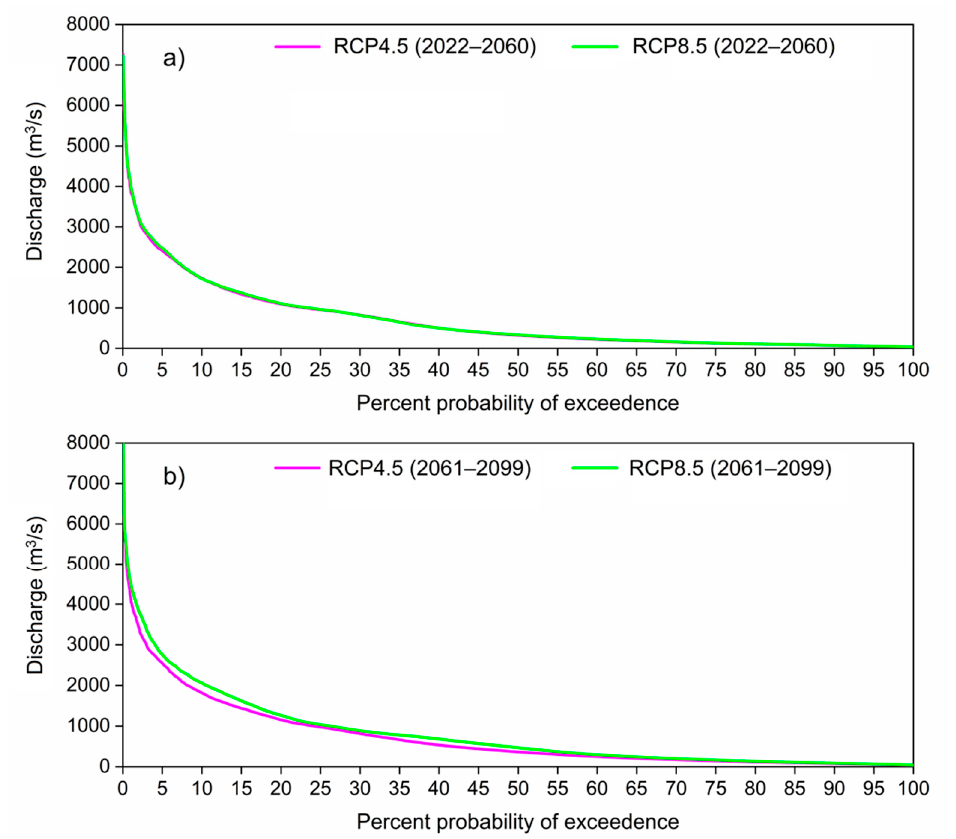
Figure 10. Flow duration curves of the study area at the Darband station based on the multi-model ensemble (MME) during ( a ) the 2022–2060 under RCP4.5 and RCP8.5 and ( b ) 2061–2099 periods under RCP4.5 and RCP8.5 in the Vakhsh River Basin, Central Asia.